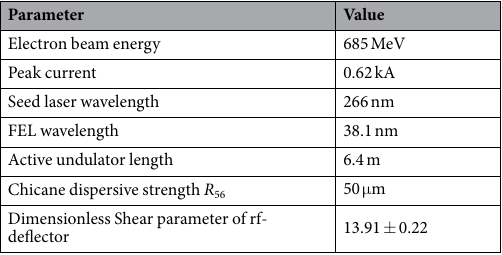
Table 1. Experimental parameters.